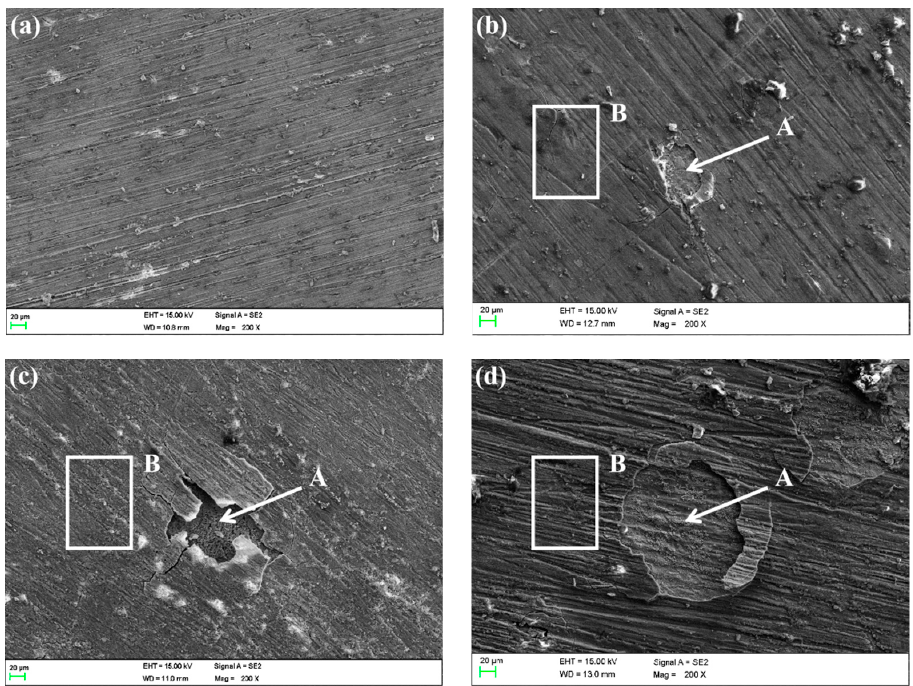
Figure 16. SEM morphology of HAZ surface in different flowing rates of seawater: ( a ) 0 m/s, ( b ) 1 m/s, ( c ) 3 m/s, ( d ) 5 m/s .